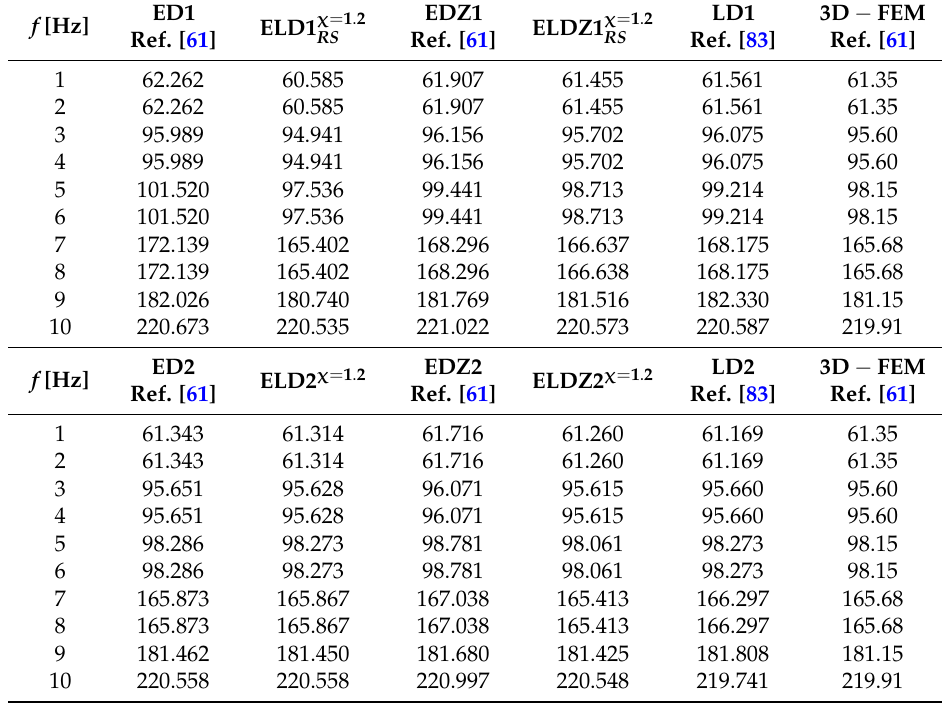
Table 11. Comparison of the natural frequencies for a laminated composite conical shell [61,83]. The solutions obtained through the present approach are compared to the results given by the corresponding ESL and Layer-Wise (LW)